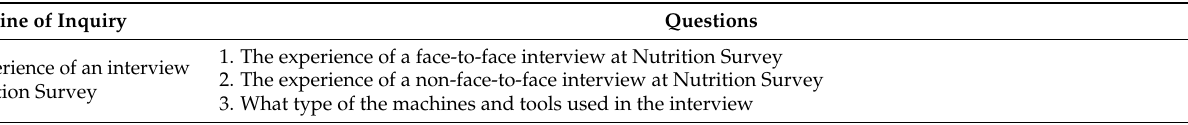
Table 1. Focus group interview